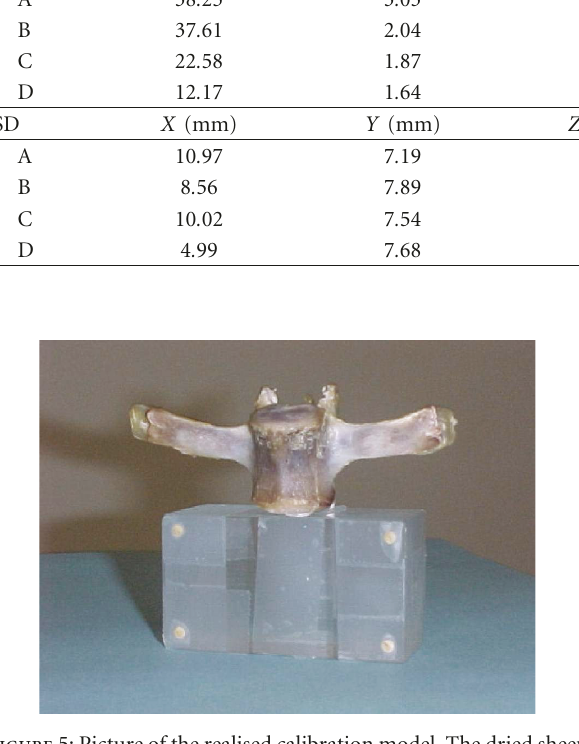
Figure 5: Picture of the realised calibration model. The dried sheep vertebra (anterior view) fixed to a radiographically transparent Perspex block measuring 72 mm by 40 mm by 34mm with eight 3mm diameter metallic markers